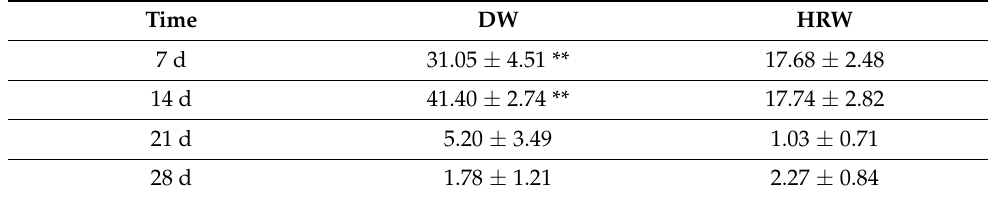
Table 6. The level of SOD (U/mg) in DW and HRW groups at days 7, 14, 21, and 28. ** p < 0.01. Time